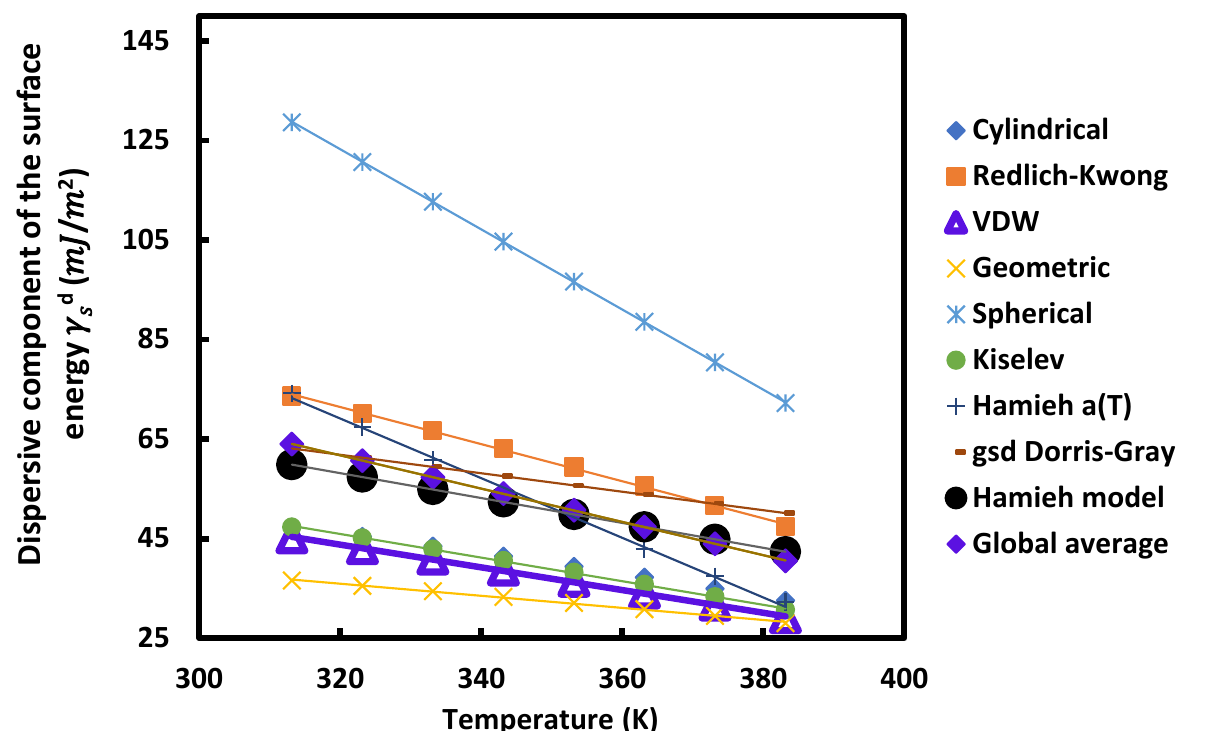
Figure 6. Variations of the dispersive component of the surface energy 𝛾 𝑠𝑑 (𝑚𝐽/𝑚 2 ) of UiO-66-AA as a function of the temperature T (K) using different models.